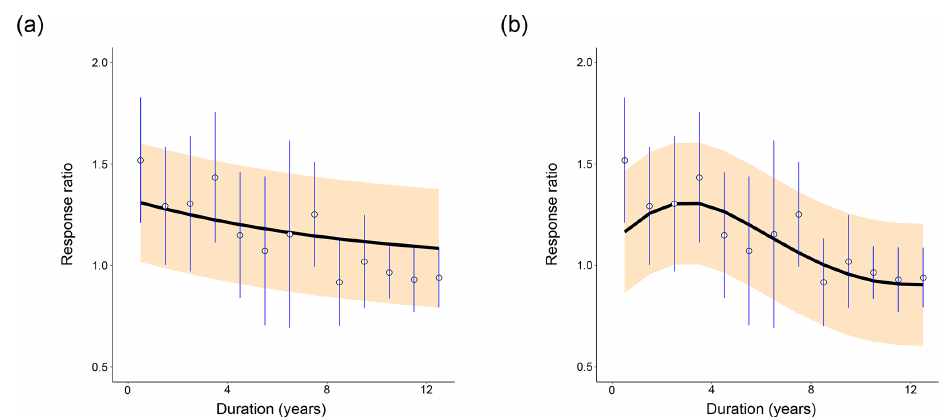
Figure 2. Distribution of fits of (a) CON and (b) AWB to the meta-analysis data from Romero-Olivares et al. (2017). Open circles show the meta-analysis data points. Blue vertical lines mark the 95% confidence interval for each data point calculated from the pooled standard deviation. The black line indicates the mean model response ratio fit. The orange shading marks the 95% posterior predictive interval for the fit. For (a) , prewarming steady-state soil C densities were set at SOC = 100mgCg − 1 soil, MIC = 2mgCg − 1 soil, and DOC = 0.2mgCg − 1 soil. For (b) , prewarming steady-state soil C densities were set at SOC = 100mgCg − 1 soil, MIC = 2mgCg − 1 soil, DOC = 0.2mgCg − 1 soil, and ENZ = 0.1mgCg − 1 soil.